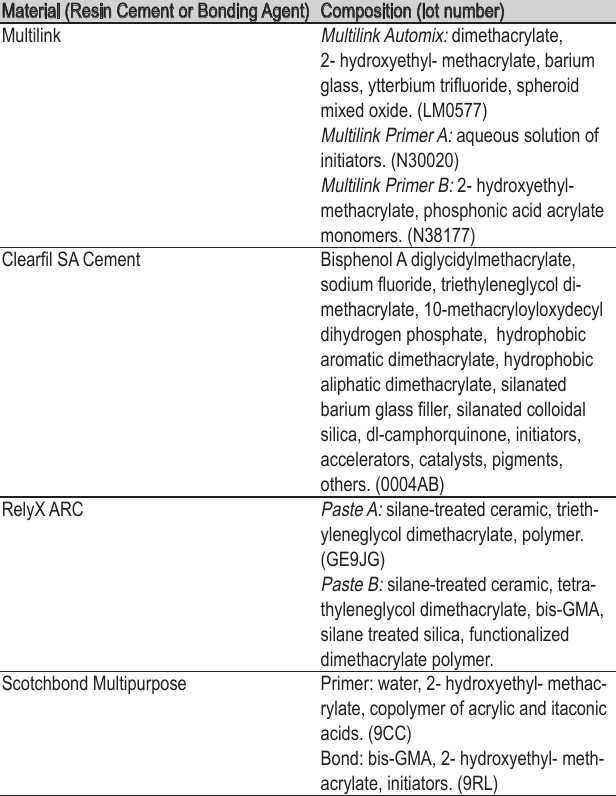
Table 1 - Compositions of the resin luting cements and bonding agents